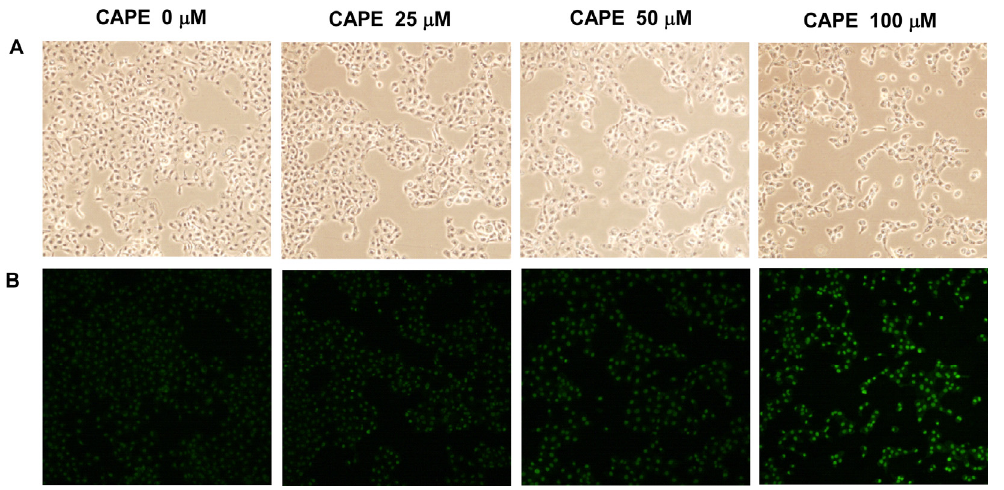
Figure 4. Treatment of high concentration of CAPE induced apoptosis in TW2.6 oral cancer cells. TW2.6 oral cancer cells were treated with 0, 25, 50, and 100 μ M CAPE for 48 h. Cell morphology was determined by light microscopy ( A ). TUNEL assay was performed as described in Material and Methods to determine the apoptotic cell population ( B ). Green fluorescent light indicated apoptotic cells stained with TUNEL. Images were viewed at 200X with Olympus confocal